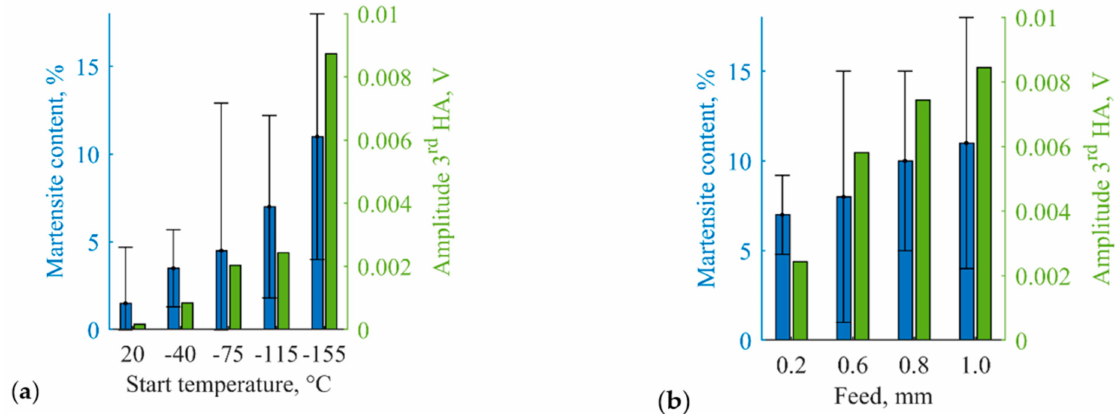
Figure 3. Correlation of martensite content and the third harmonic of the eddy current signal after turning AISI 304 with ( a ) variable workpiece start temperatures and ( b ) variable feed rates; see also